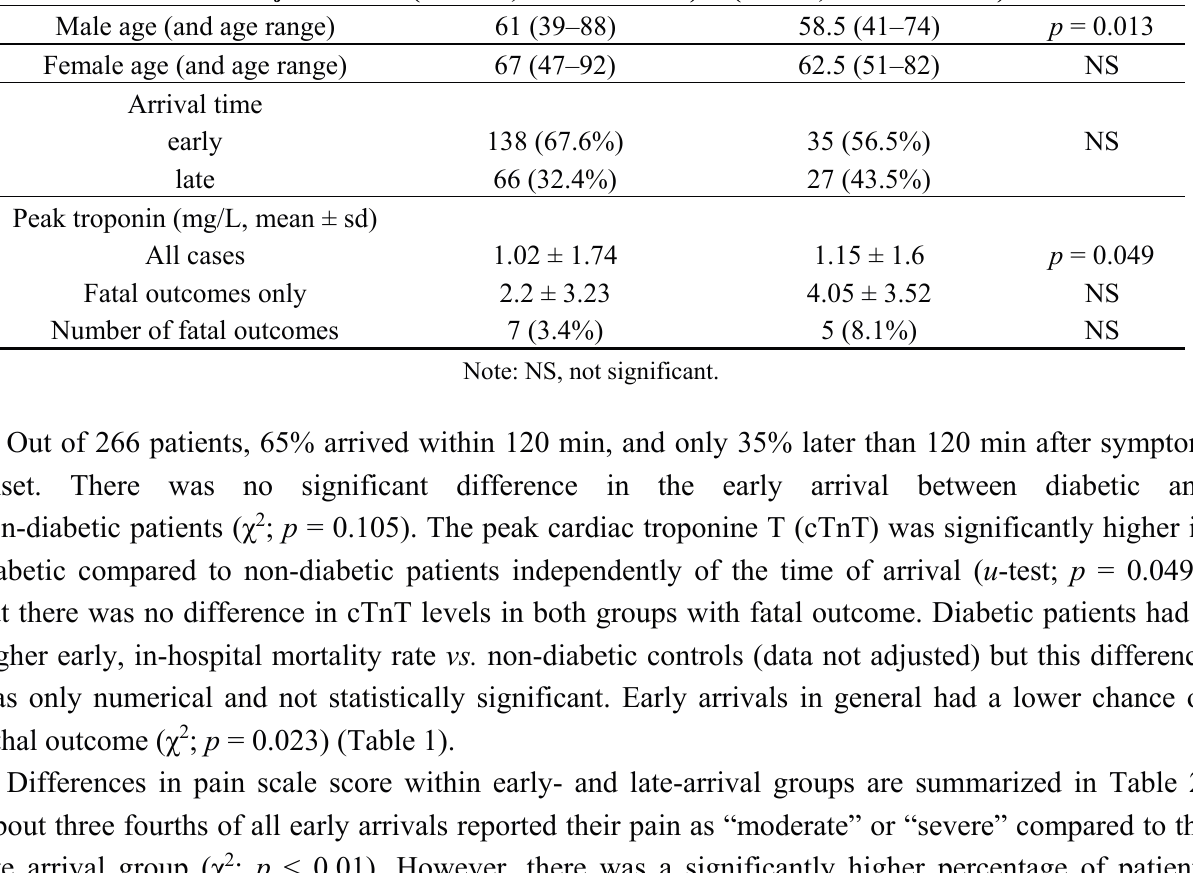
Table 1. Baseline characteristics of subjects and arrival time in diabetic and non-diabetic group. Baseline Characteristics